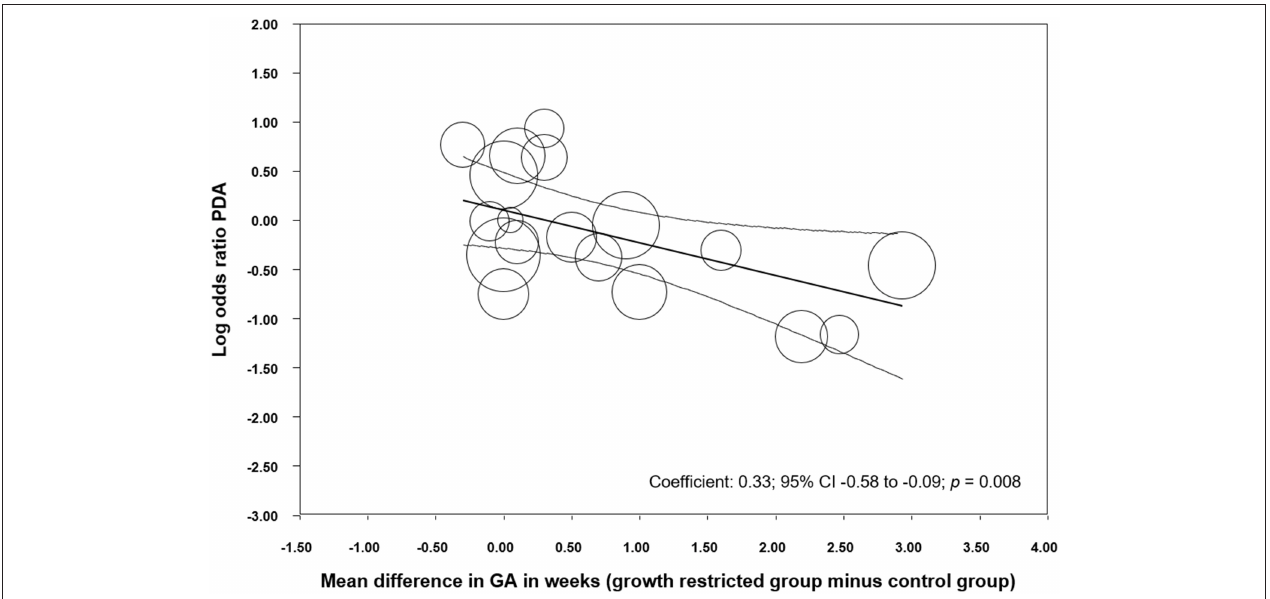
FIGURE 4 | Meta-regression of mean difference in gestational age (GA) between growth restricted and control groups and risk of developing patent ductus arteriosus (PDA). CI: confidence interval.